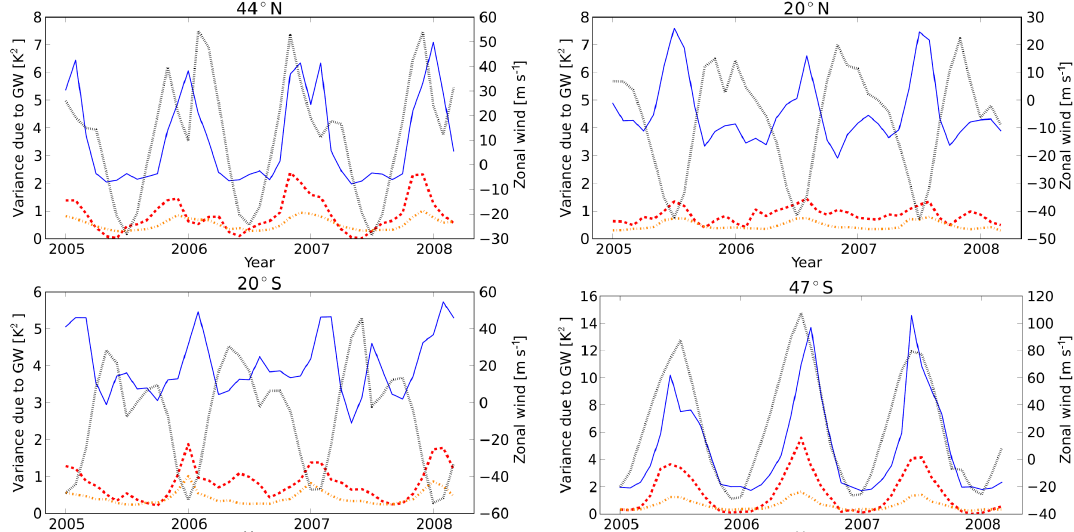
Figure 12. Time series of monthly mean gravity wave variances for measurements between 2005 and 2008 at 42km altitude and different latitudes (see plot titles). Orange dash-dotted lines: AIRS operational retrieval. Red dashed lines: AIRS high-resolution retrieval. Blue lines: HIRDLS. Black dotted lines indicate zonal mean winds at 2.5hPa from ERA-Interim.